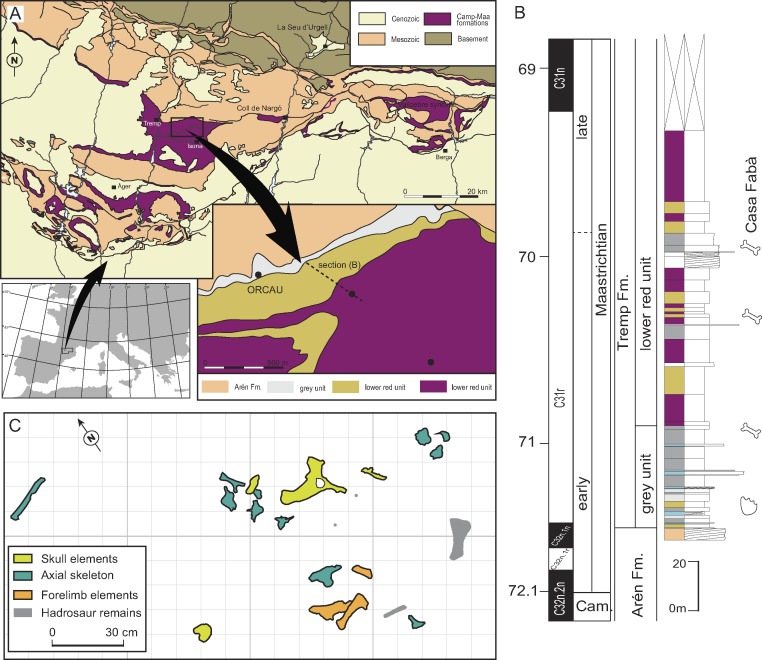
Geographical and geological location of the Casa Fabà site.(A) Geological map of the Tremp Basin (modified from López-Martínez & Vicens, 2012); (B) stratigraphical section performed near the Casa Fabà site (modified from Riera et al., 2009); (C) mapping of the crocodilian bones at the Casa Fabà locality.